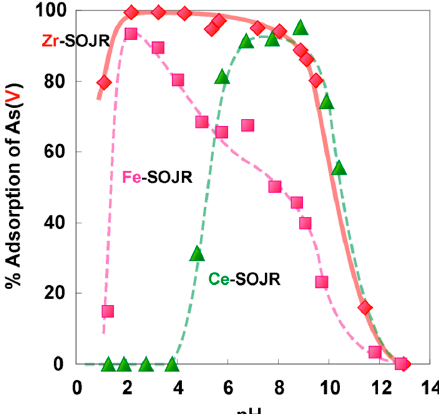
Figure 22. % adsorption of As(V) by SOJR gel loaded with Fe(III), Ce(III) and Zr(IV) at different equilibrium pH values [16]. (With permission for reuse from Indonesian Chemical Society).